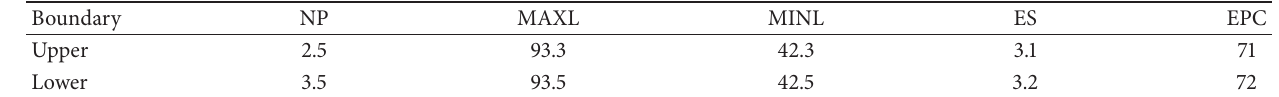
Figure 6: SPEA2 Pareto frontier when the maximum generations are 20, 50, 100, and 200. (a) Maximum generation is 20, (b) maximum generation is 50, (c) maximum generation is 100, and (d) maximum generation is 200. Table 4: Searching boundaries of the parameters.